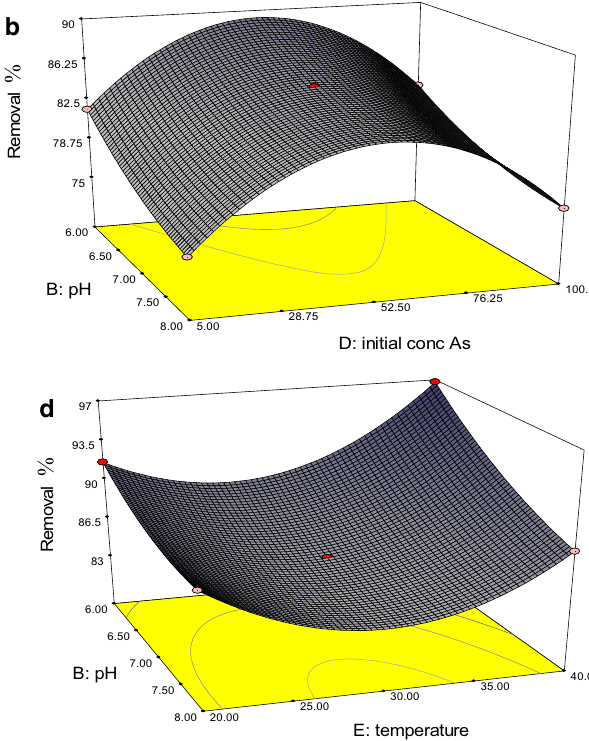
c adsorbent dose (0.05–0.3 g) and the pH of the adsorbent MPKSF suspension (6–8); d temperature (20–40 (cid:3) C) and the pH of the adsorbent MPKSF suspension